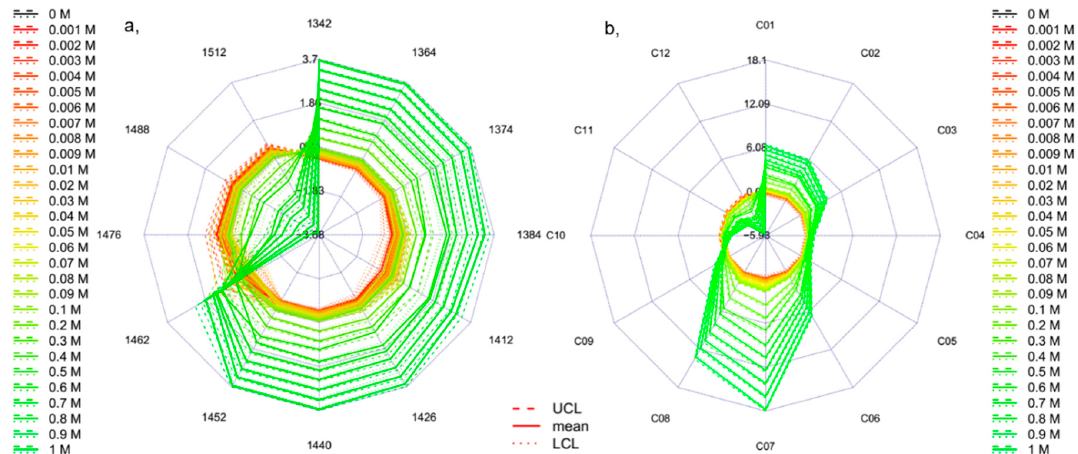
Figure 5. Aquagrams with 95% confidence intervals of Milli-Q water ( n = 150) and 0.001–1 M KCl solutions ( n = 180) calculated with the classic ( a ) or the temperature based aquagram ( b ) calculation methods on the individual concentrations (UCL—upper confidence level, LCL—lower confidence level).